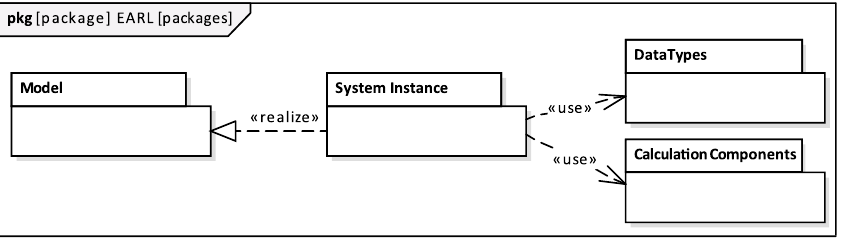
Figure 1. EARL package